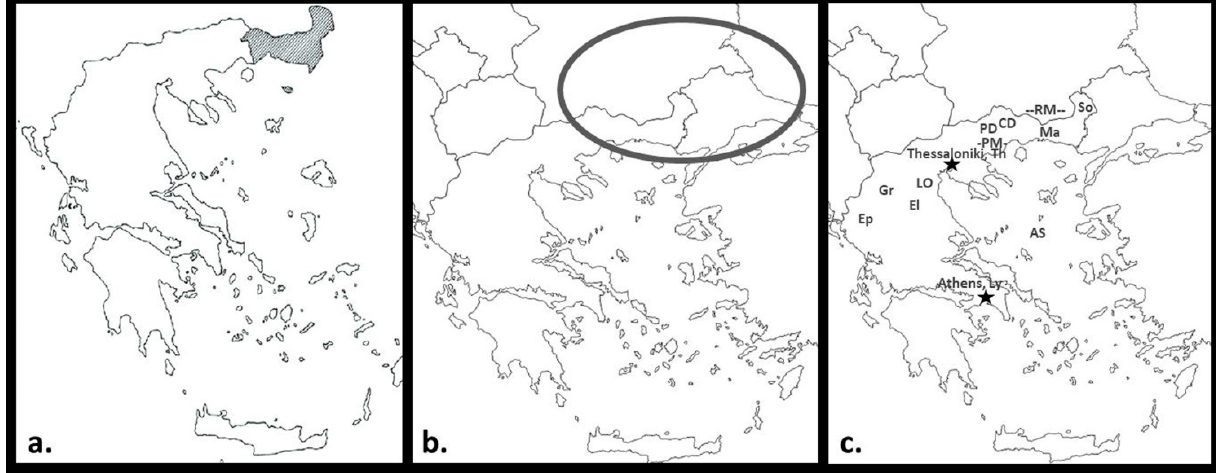
Figure 1. ( a ) Map of (modern) Greek Thrace (grey-colored). ( b ) Area of ancient Thrace (in the black elliptic circle). ( c ) Locations of the main sites mentioned in the manuscript: So: Soufli, Ma: Maronia, RM: Rhodope Mountains, CD: Choristi,